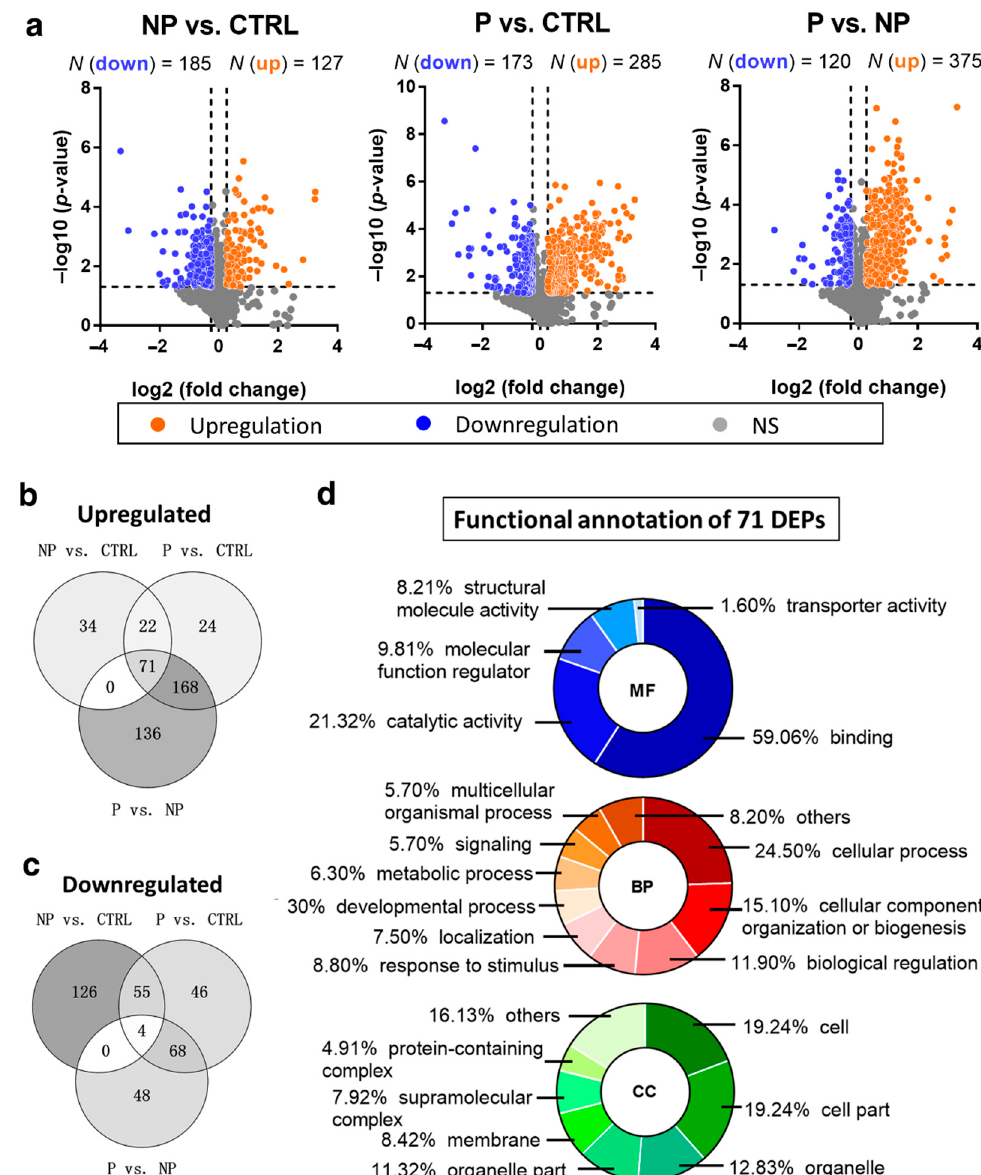
Figure 2. Analysis of differentially expressed proteins (DEPs). ( a ) Volcano plot of the relative quantitation results. A t -test was used between groups. Proteins with a ratio of ≤ 0.83 or ≥ 1.2 and a p -value < 0.05 were considered as DEPs. Blue and orange plots indicate down and upregulated DEPs, respectively. Gray plots represent non-significant (NS) proteins. ( b , c ) Venn diagrams show the overlap among all down and upregulated DEPs in the three comparison groups: NP vs. CTRL, P vs. CTRL, and P vs. NP. ( d ) PANTHER Gene Ontology (GO) functional categorization of upregulated DEPs presented in all of the comparison groups in ( b ). MF, BP, and CC represent the GO aspects molecular function, biological process, and cellular component, respectively. The percentage of each term was calculated as a protein hit the term/total function hits. The BP and CC terms less than 4% were combined as “others”.